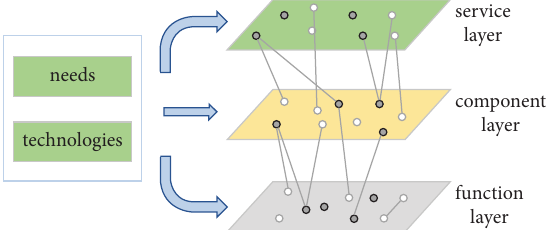
Figure 1: Te fve elements of ATS work as shown in the fgure. Needs and technologies as external drivers, functions and services as internal infuences, and components as physical carriers, the system is organized as a